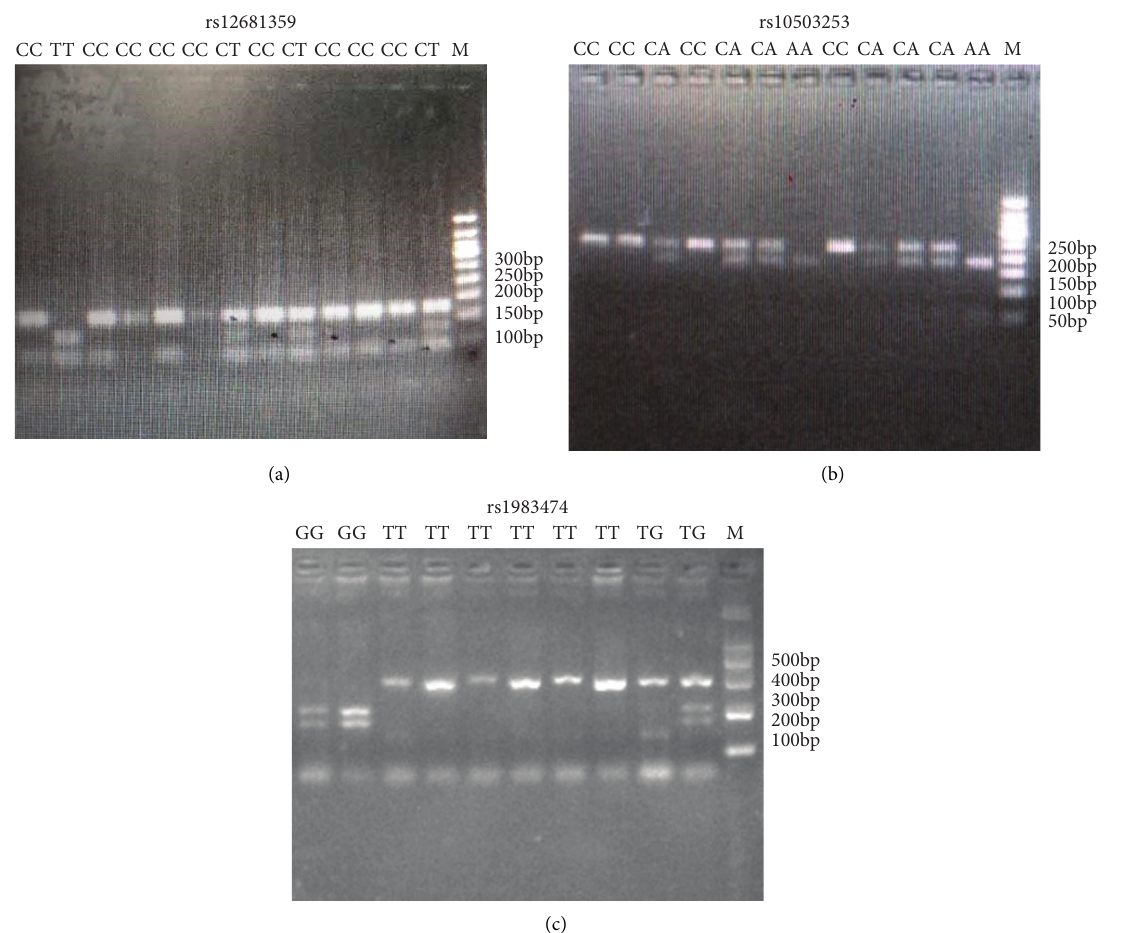
Figure 1: Polymorphism for rs12681349 (CC/CT/TT), rs10503253 (CC/CA/AA), and rs1983474 (GG/TG/TT) was genotyped by PCR- RFLP. Table 2: Specific information on the PCR-RFLP reaction process of the three SNPs of CSMD1.